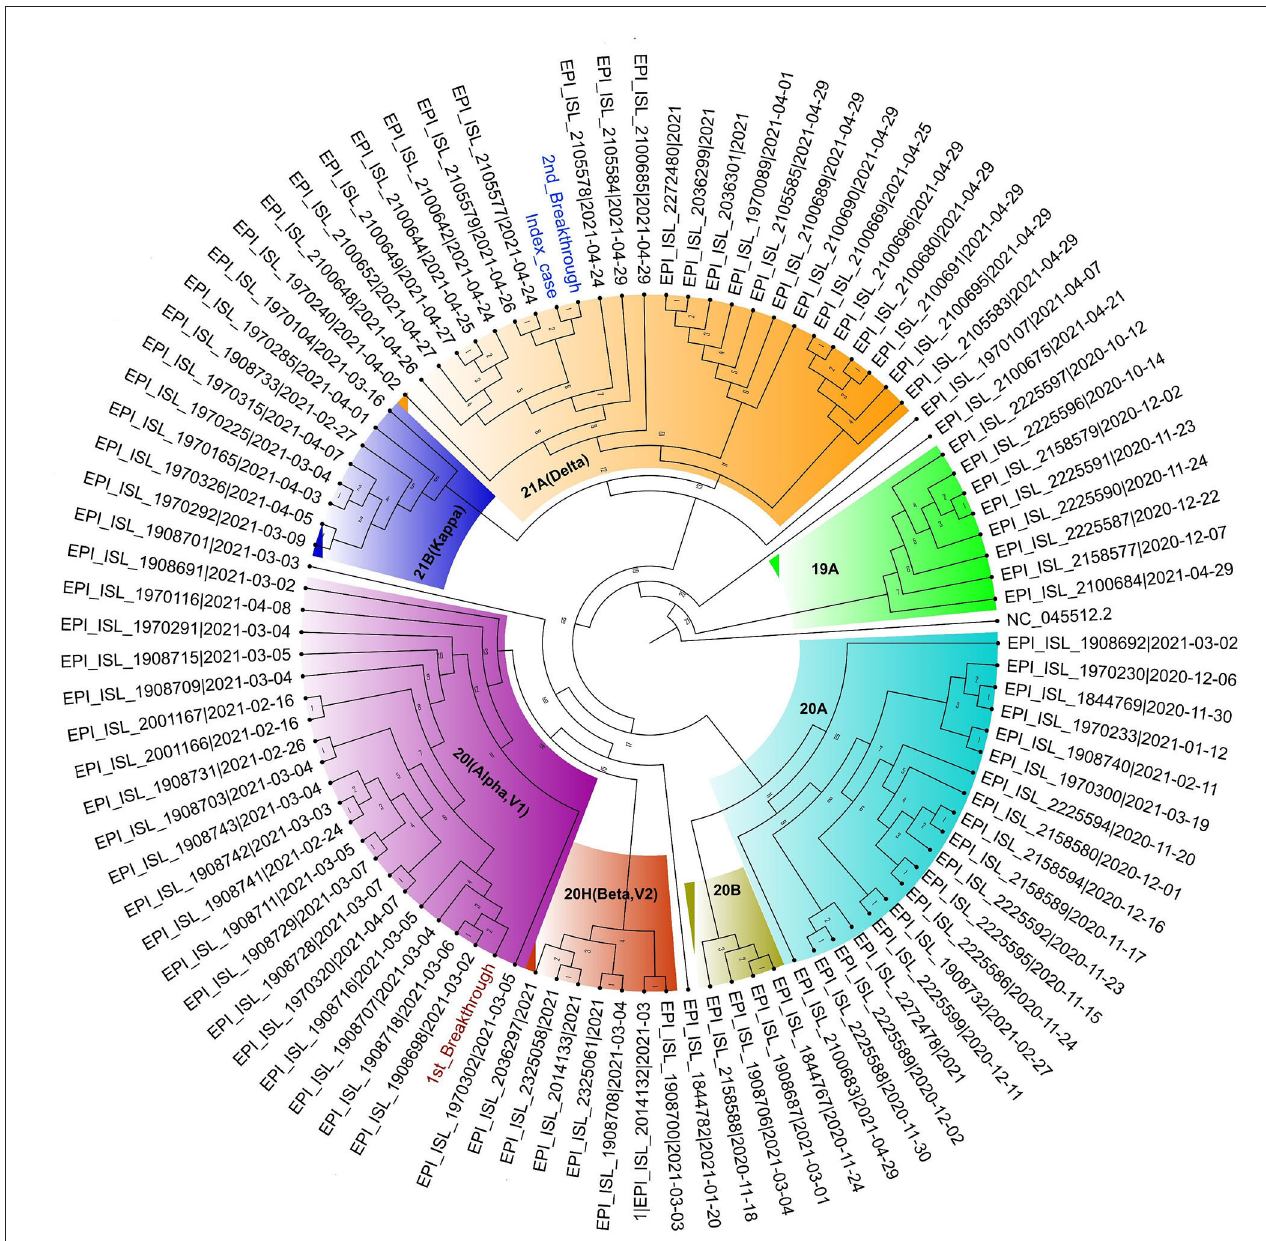
FIGURE 4 | Circular Phylogram of 100 sequences used in the analysis. The Patient’s first breakthrough sequence falls in the clade 20I (Alpha, V1) (text in brown) and second breakthrough sequence belongs to clade 21A (Delta) (in blue). The index case sample is also seen to fall close to the second breakthrough sample in clade 21A (Delta) (text in